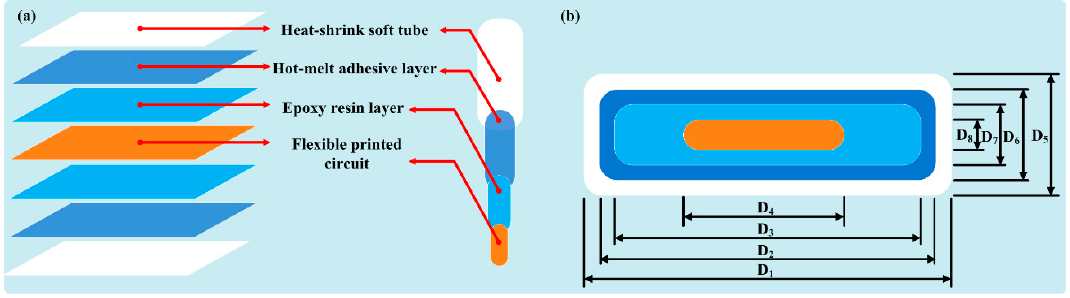
Figure 2. ( a ) Inner structure of the thermistor string. ( b ) Cross-sectional view of the thermistor string.